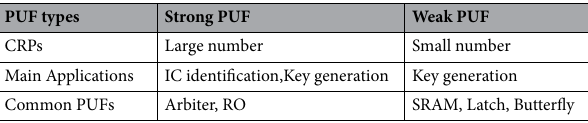
Table 2. Strong versus weak